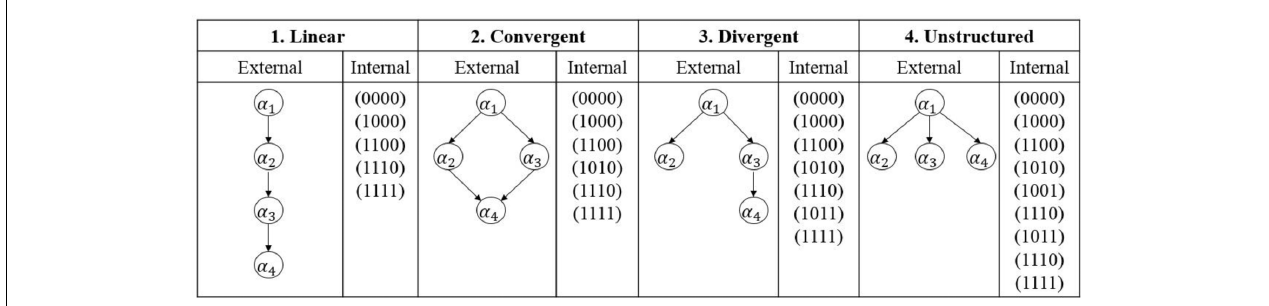
FIGURE 1 | Types of hierarchical attribute structures. For the convergent structure, mastering α 4 needs to master both α 2 and α 3 (Zhan et al., 2020), as well as α 1 .